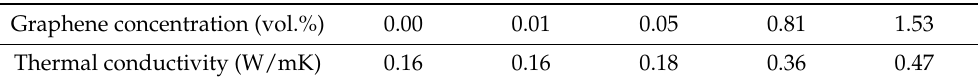
Table 1. Thermal conductivity of polystyrene/graphene nanocomposites with different nanofiller contents [80]. Reproduced with permission from Elsevier.